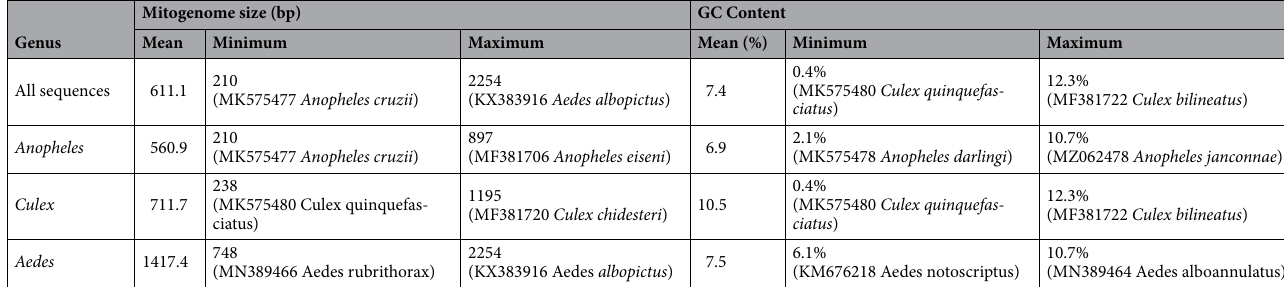
Table 2. Size and GC content of Culicidae mitogenome control region by